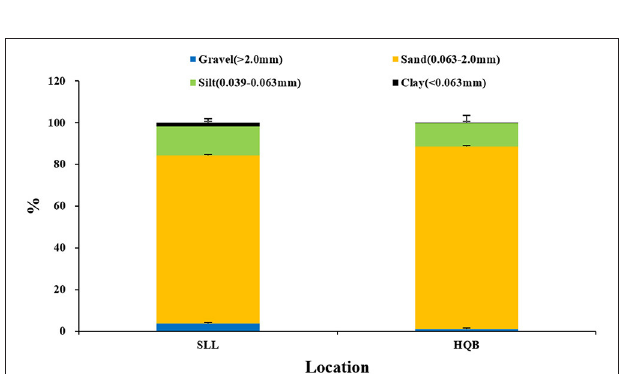
FIGURE 4 | Sediment grain sizes at Swan Lake (SLL) and Huiquan Bay (HQB).